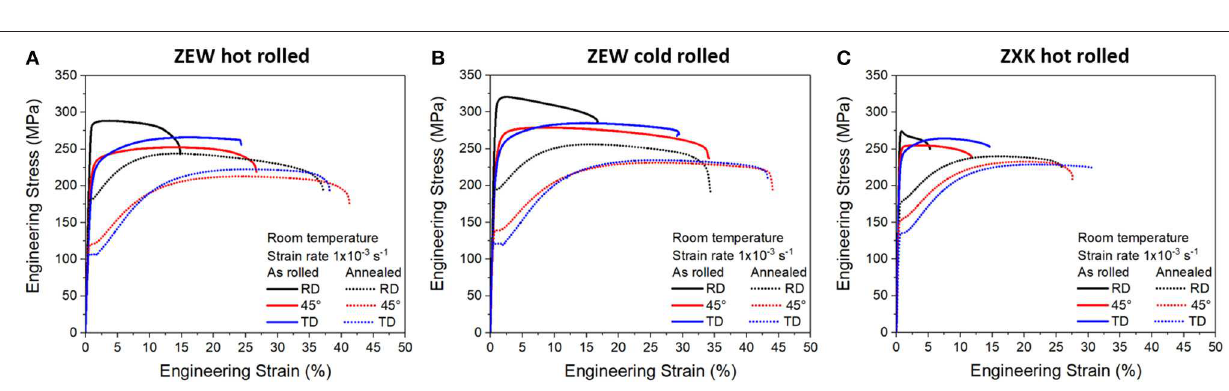
FIGURE 3 | Engineering stress-strain curves for the (A) hot rolled ZEW200 alloy, (B) cold rolled ZEW200 alloy, and (C) hot rolled ZXK alloy in as-rolled and annealed conditions,